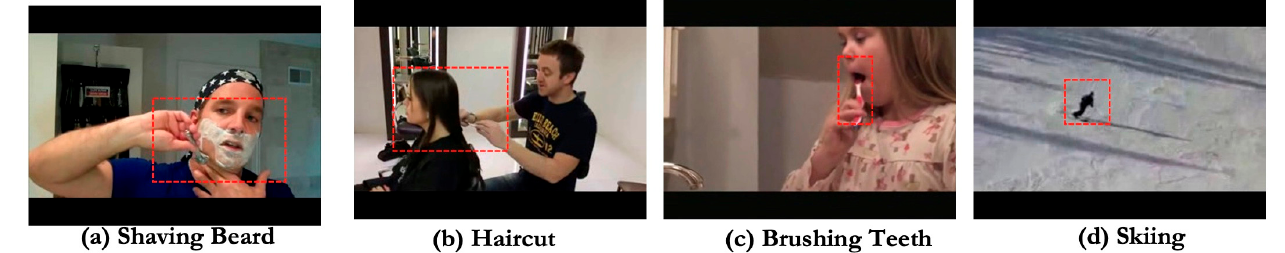
Figure 1. Examples of four video frames from the UCF-101 video dataset. From ( a ) to ( d ) all represent a video frame in which the action target occurs in a specific spatial region .